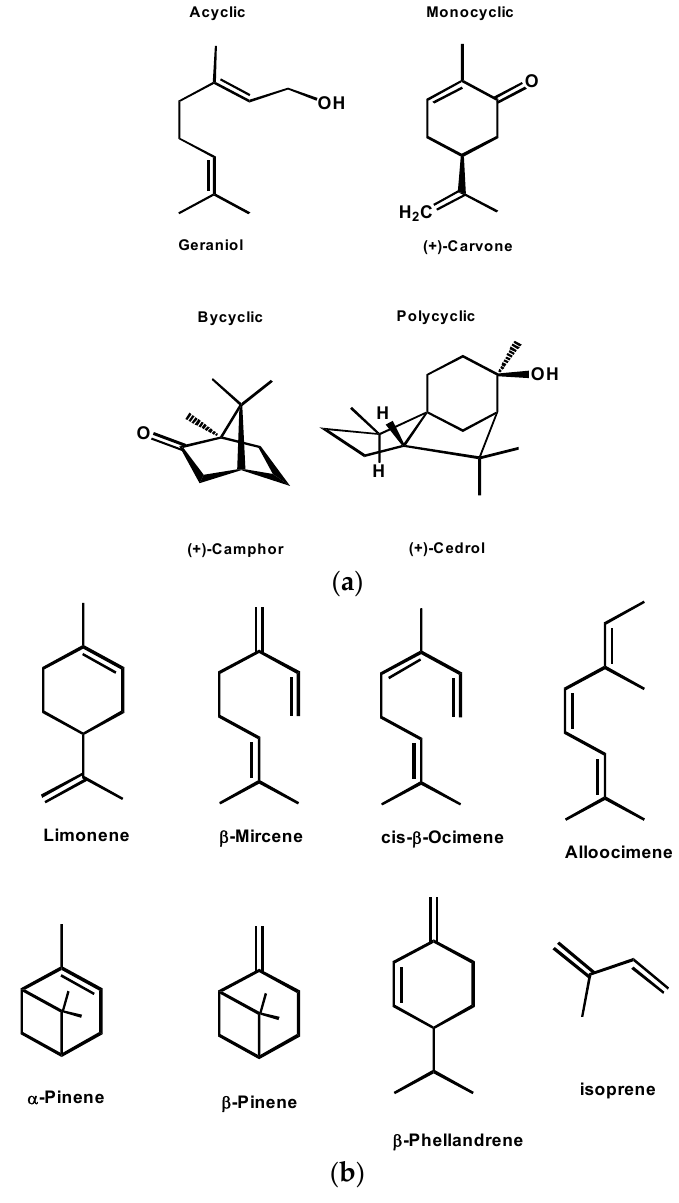
Figure 6. ( a ) Different classes of terpenes. ( b ) Common terpenes and terpenoids.